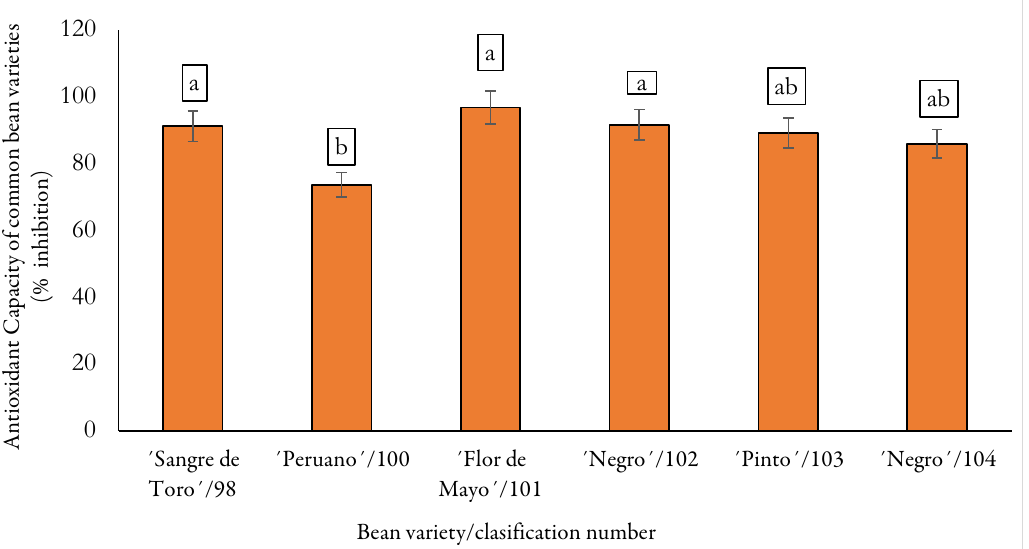
Figure 1. Antioxidant capacity of common bean varieties grown in Morelos State, Mexico. Means with the same letter are not significantly different, Tukey test (p ≤ 0.05). *Laboratory work